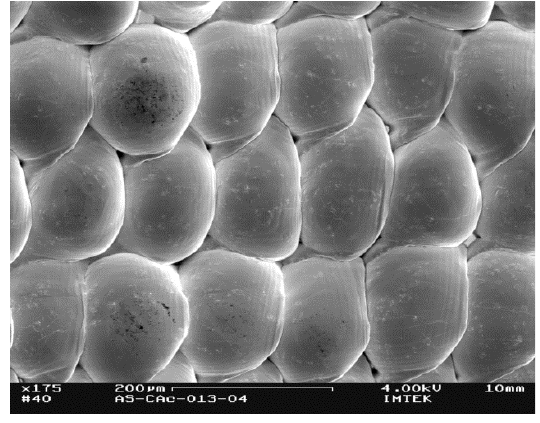
Figure 16. Close up view (SEM picture) of in DoD-mode wall; droplet diameter approximately 144 μ